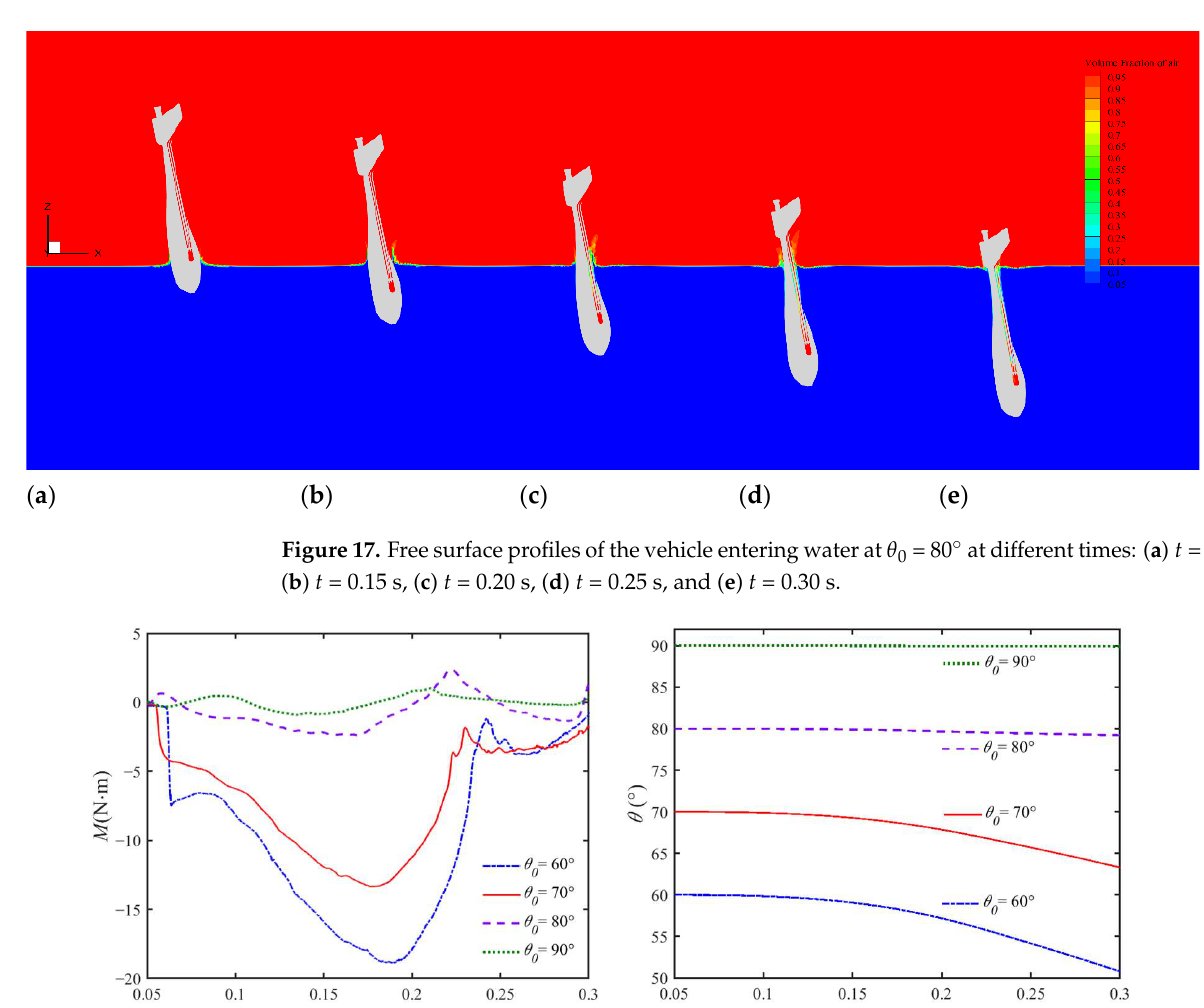
Figure 16. Free surface profiles of the vehicle entering water at θ 0 = 70° at different times: ( a ) t =